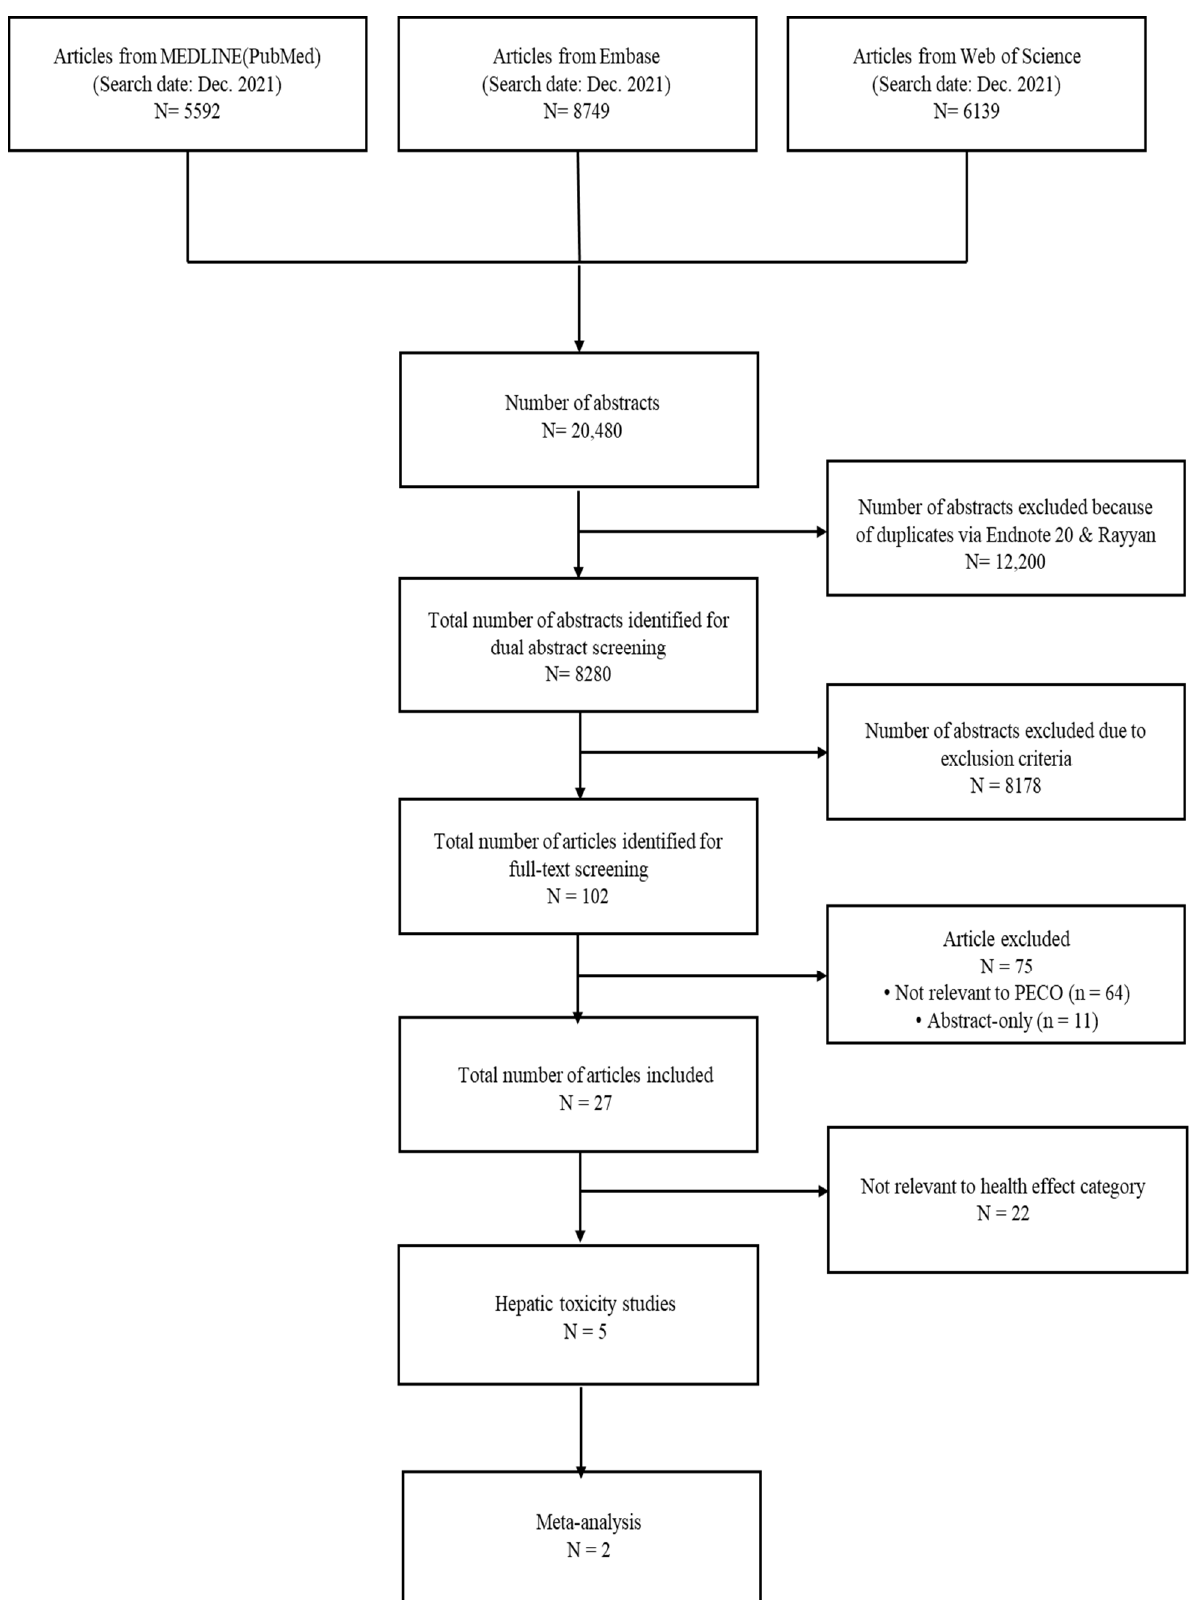
Figure 1. Flow diagram presenting the search and selection processes of the meta-analysis using studies on the exposure to PFOA in hepatic disease.